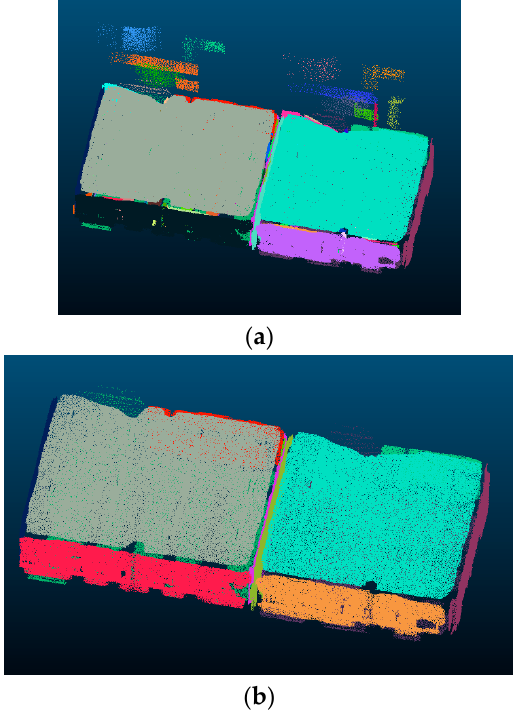
Figure 19. Scenario 3: ( a ) Plane Segmentation; ( b ) Wall Clustering.